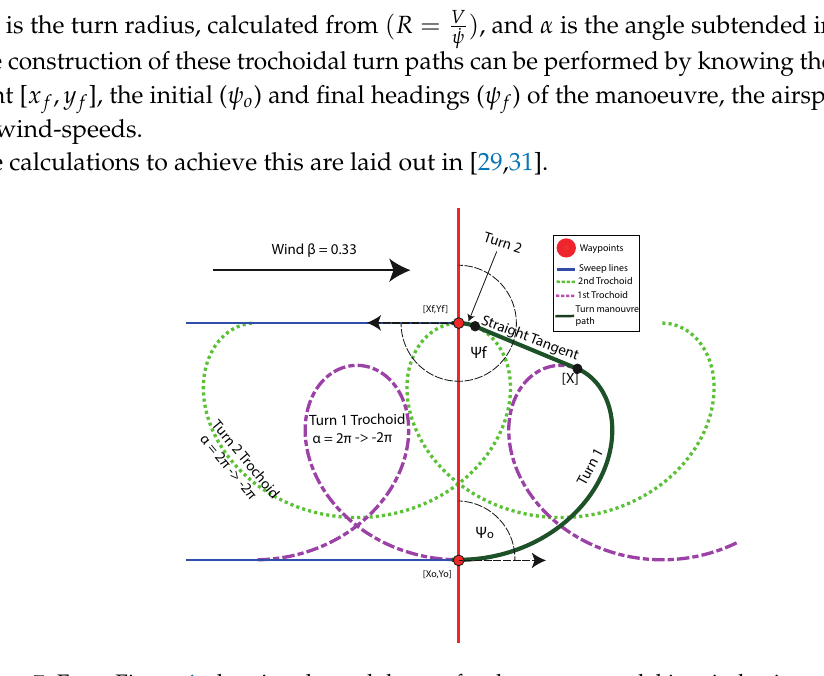
Figure 7. From Figure 4, showing the path layout for the survey model in wind using trochoidal turn paths in addition to the the full trochoids for α of 2 π → − 2 π , where portions of these are used to generate the paths. In this example, the aircraft is flying sweeps parallel to the wind direction, known from Theorem 1 to be the least